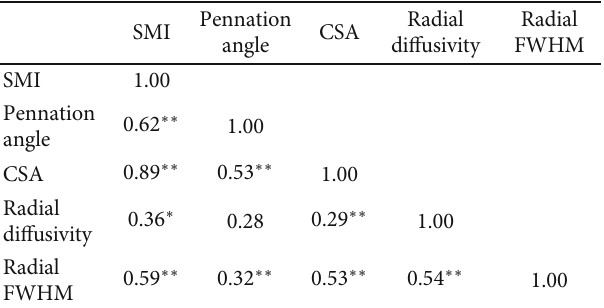
Table 4: Summary of the correlation between muscle parameters and magnetic resonance imaging parameters of the gastrocnemius